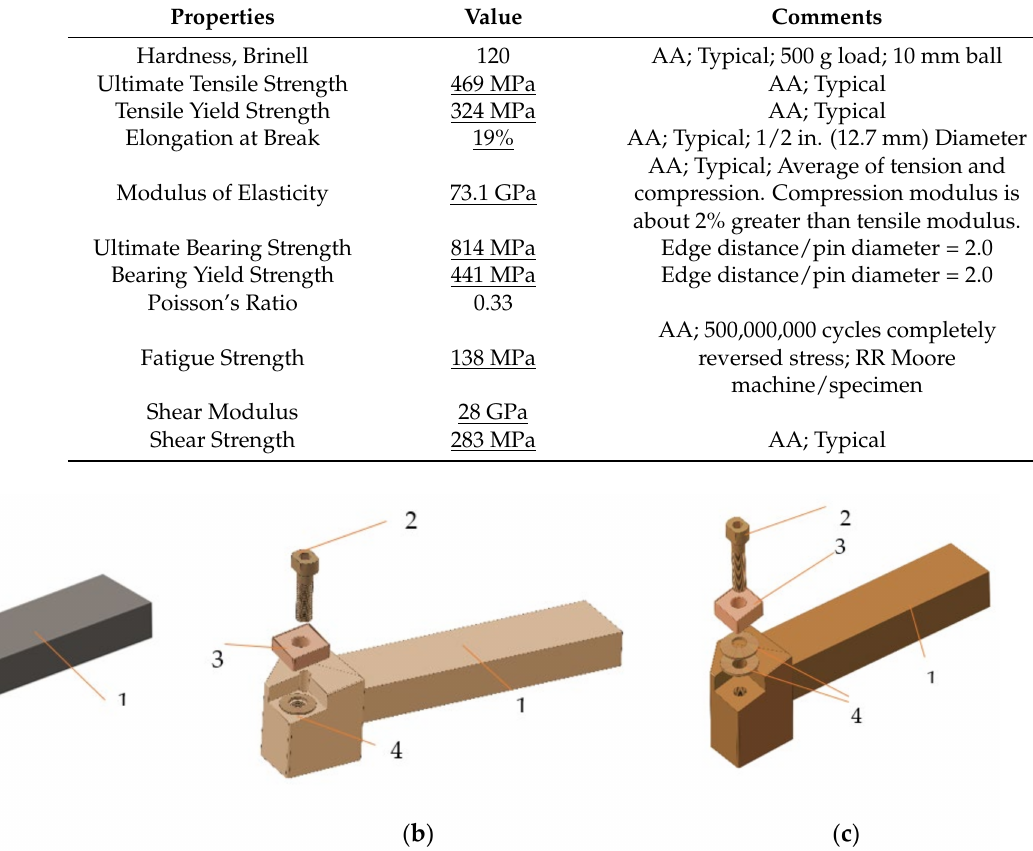
Figure 1. Knives for frontal turning: ( a ) in the classic version (T01); ( b ) with improved constructive form with a spring washer (T02); ( c ) with improved constructive form with two spring washers (T03); 1—knife body; 2—screw fixing; 3—removable plate; 4—spring